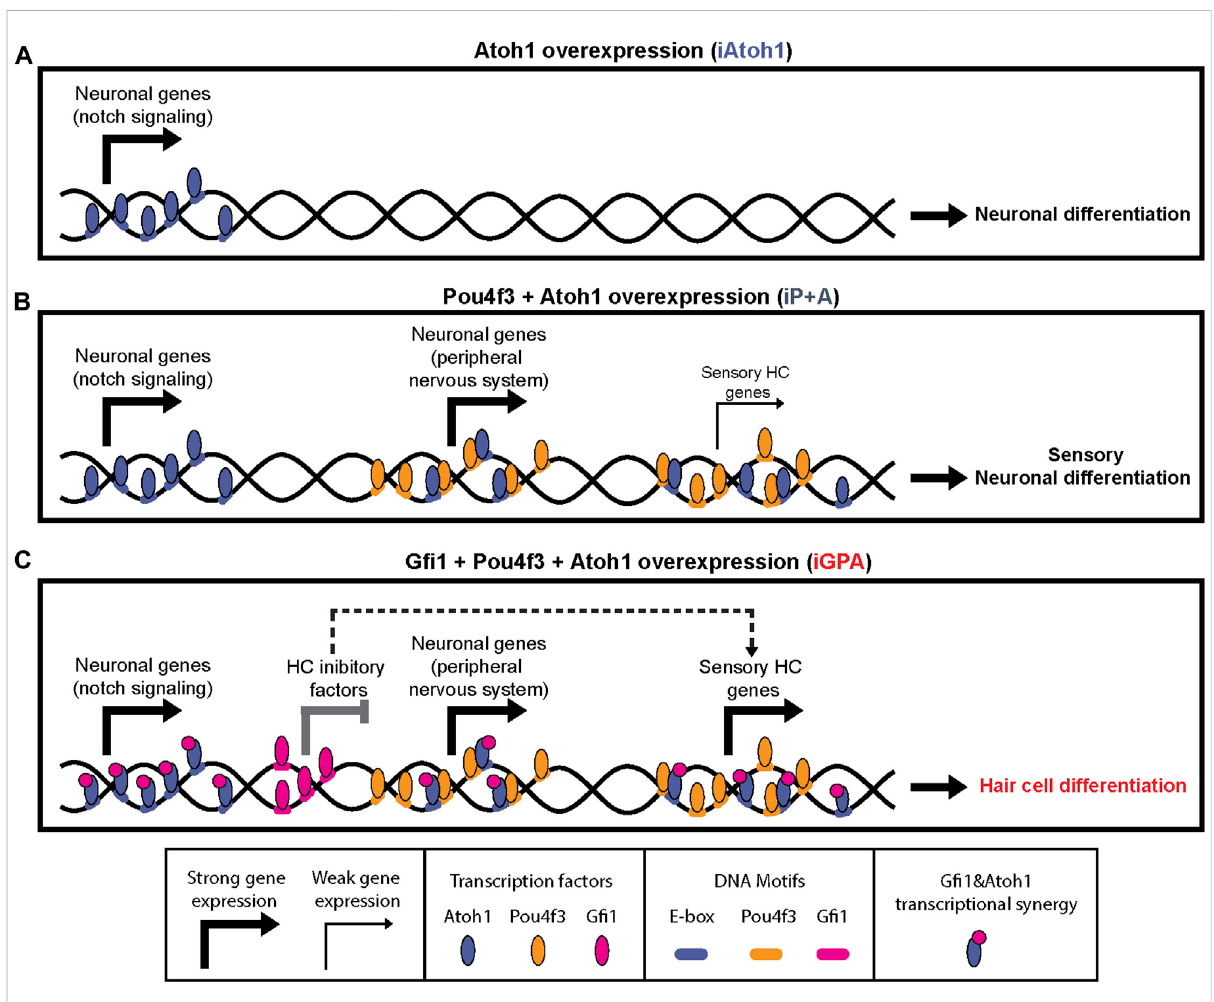
Pou4f3 and G fi 1 contribute different mechanisms in converting Atoh1 to an HC determinant in mESCs. Schematic summary of fi ndings and possible interpretation. (A – C) Atoh1 binds to neuronal targets in all conditions. (B) Presence of Pou4f3 recruits Atoh1 (partly directly) to sensory targets (neuronal and HC) but this does not result in strong HC gene upregulation. (C) G fi 1 has a dual function in HC differentiation: it binds to and represses some targets that would otherwise interfere with HC differentiation; it cobinds via interaction with Atoh1 to sensory and HC targets where it promotes